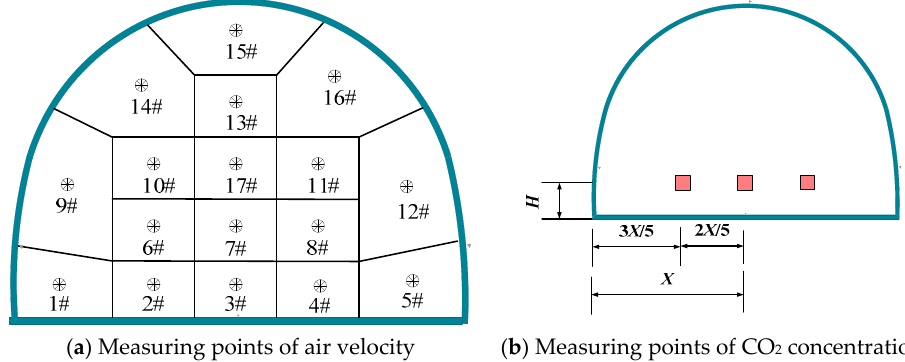
Figure 16. Distribution of velocity measuring points.